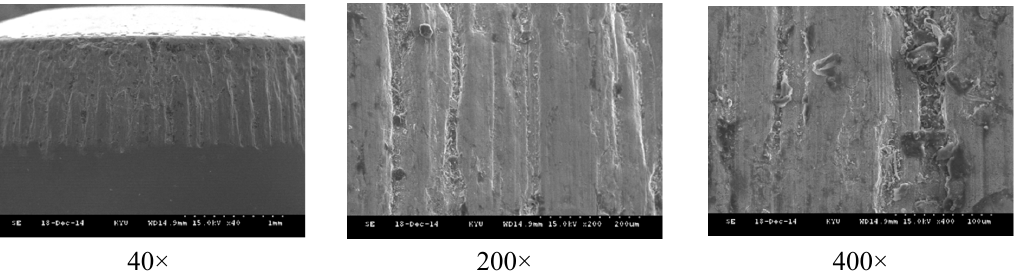
Figure 18. SEM micrographs of the worn surface of an upper punch at various magnifications.